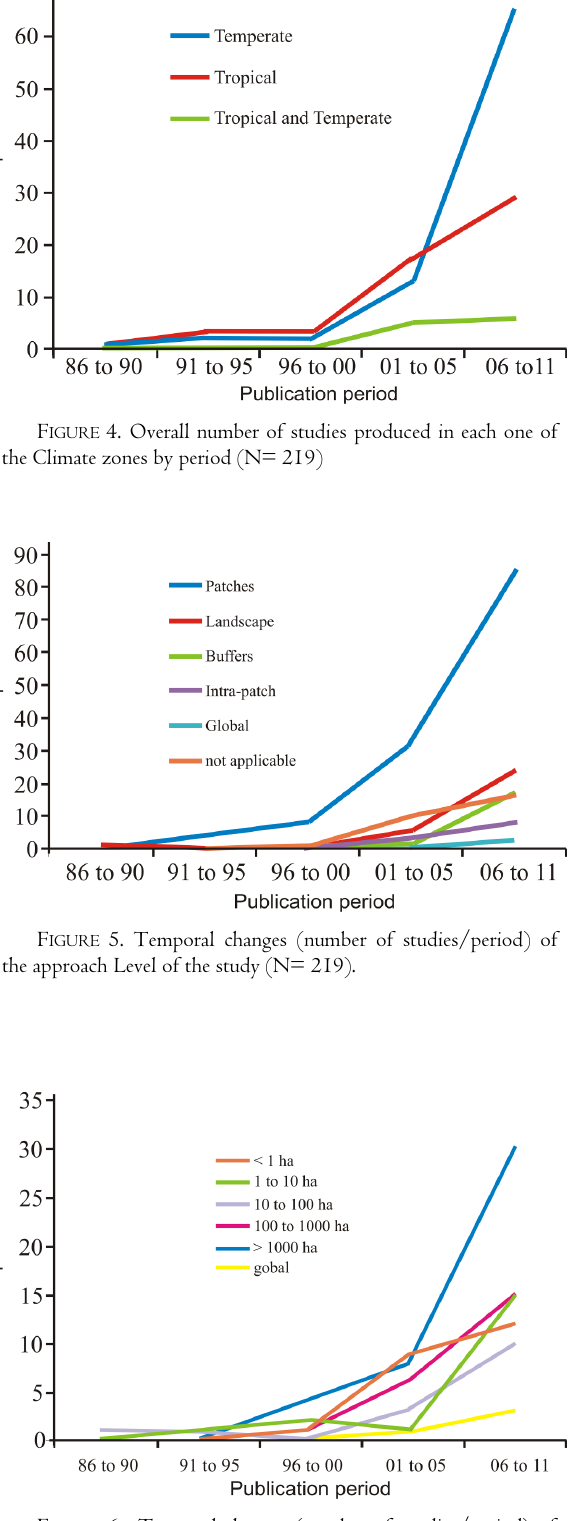
F IGURE 6. Temporal changes (number of studies/period) of landscape or patch size where the studies were carried out. Only those studies that specified patch or landscape size were considered. (N=